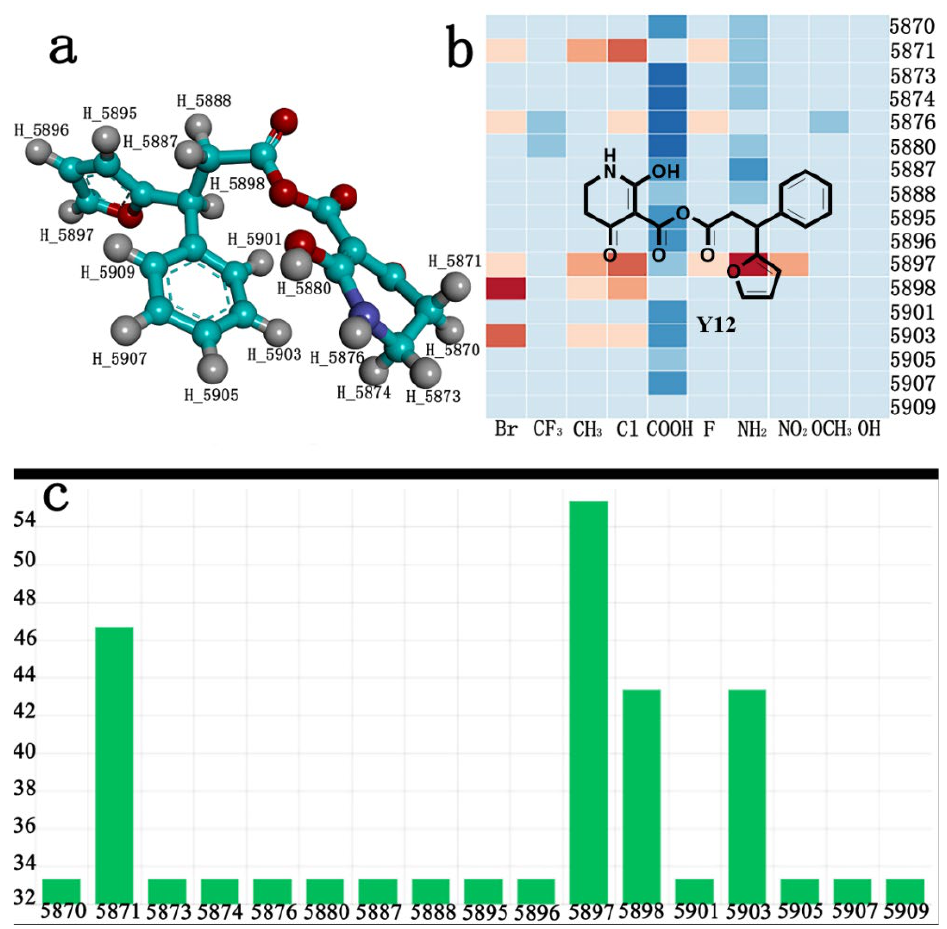
Figure 10. ( a ) Hydrogen serial numbers; ( b ) Heat map showing the relationship matrix between the substituent positions and substituents (darker red colors indicate compounds with better activities); ( c ) Histogram illustrating the overall result based on substituent positions, which helps to elucidate which positions possess the most potential for substitution (X: Hydrogen number, Y: